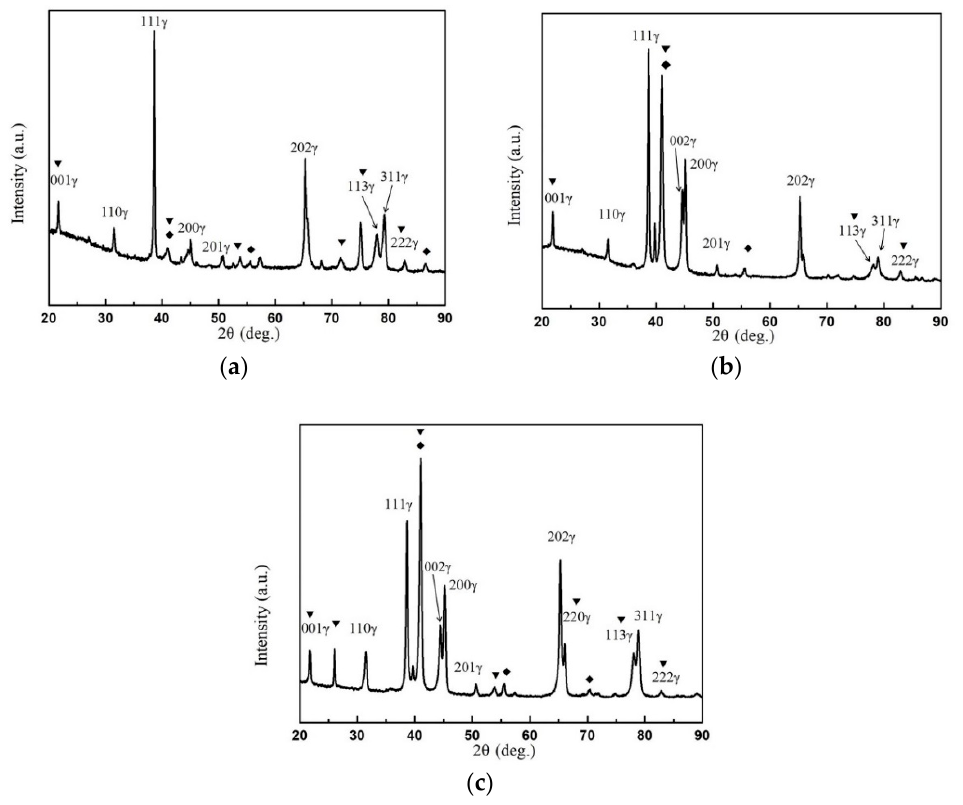
Figure 4. X-ray diffraction pattern of the quenched zone of the DS Ti-44Al-9Nb-1Cr-0.2W-0.2Y alloy at different growth rates: ( a ) V = 10 μ m/s; ( b ) V = 15 μ m /s; and ( c ) V = 20 μ m/s ( ▼ α 2 -Ti 3 Al phase, ♦ B2 phase).